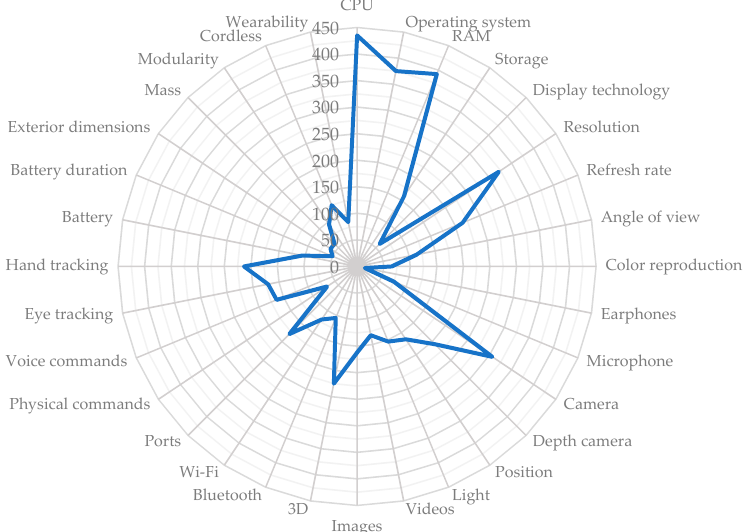
Figure 2. Device specification relative importance for oncological and reconstructive surgery.